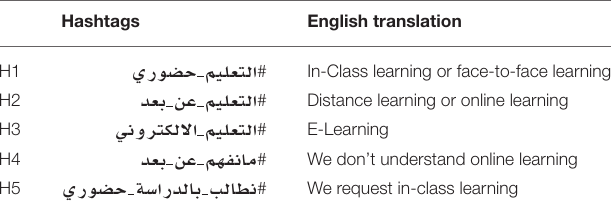
Table 1 | The list of twitter hashtags used for the data